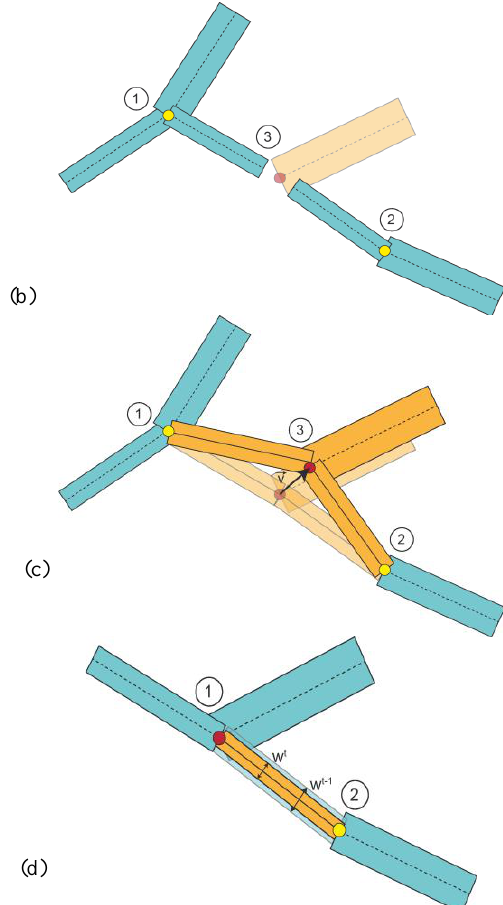
Figure 2: Four types of changes are defined for the sampling process. Nodes and segments which are chosen for a change are depicted in red and orange. The configuration before the change is depicted slightly transparent. The medial axes of the segments are illustrated by a solid line if they belong to an edge in the graph. (a) Birth kernel: Node 3 is added to the graph. Neighbouring nodes are connected by edges if they fulfil some criteria. Segments of the neighbouring nodes whose angle ω to the new direction is below a predefined threshold are removed (transparent segment of node 1). (b) Death kernel: Node 3 is removed from the configuration. Nodes 1 und 2 retain a segment in the direction of the removed node. (c) Translation kernel: The position of node 1 is changed by the displacement vector . Edges to neighbouring nodes are retained if they do not lead to crossing edges. (d) Modification kernel: The parameters of one of the outgoing segments of node 1 are changed. Because the segment belongs to an edge, the parameters of node 2 are changed,